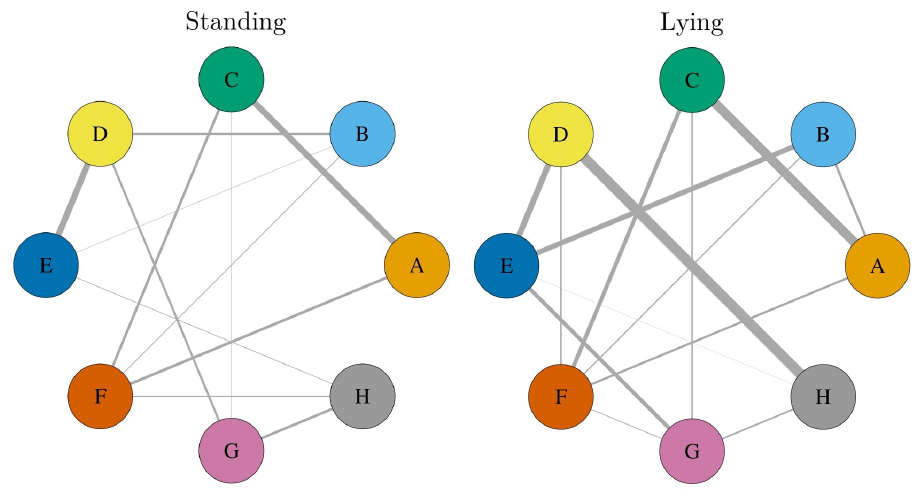
Figure 7. Social networks constructed for standing and lying heifers, respectively. Nodes represent heifers labeled by their ID, and edges represent identified contacts after applying the APC procedure. The edge width reflects the strength of the